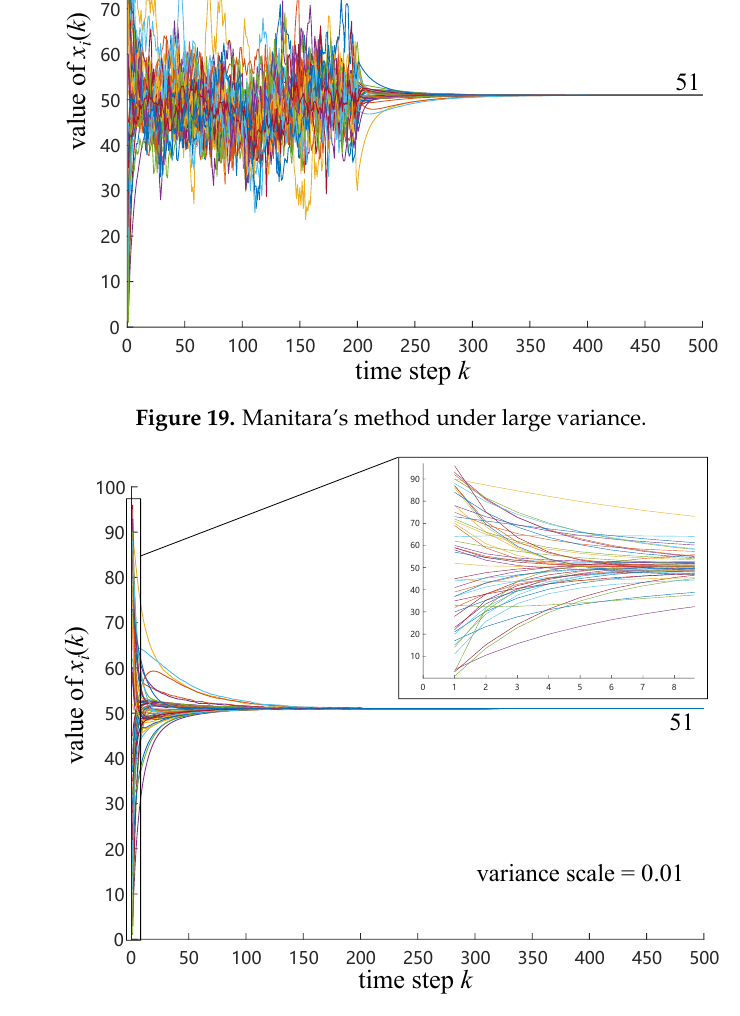
Figure 20. Manitara’s method under small